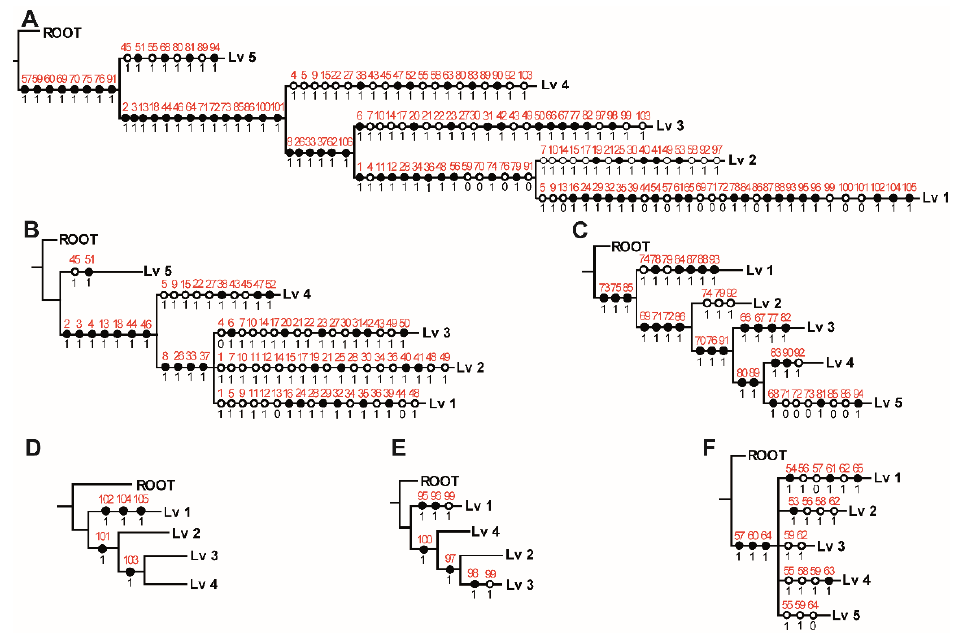
Figure 4. Parsimony Analysis of Endemism (PAE) from the five levels sampled at the Tacaná volcano Biosphere Reserve (Chiapas, Mexico). ( A ) Neuroptera fauna (one most parsimonious tree); ( B ) Chrysopidae fauna (one most parsimonious tree); ( C ) Hemerobiidae fauna (one most parsimonious tree); ( D ) Myrmeleontidae fauna (one most parsimonious tree); ( E ) Mantispidae fauna (one most parsimonious tree); ( F ) Coniopterygidae fauna (strict consensus of three most parsimonious trees). Lv1 = 650–810 m; Lv2 = 1050–1390 m; Lv3 = 1400–1770 m; Lv4 = 2000–2470 m; Lv5 = 2870–3360 m. Red numbers = Neuroptera species (see Table S1); 0 = absence; 1 =